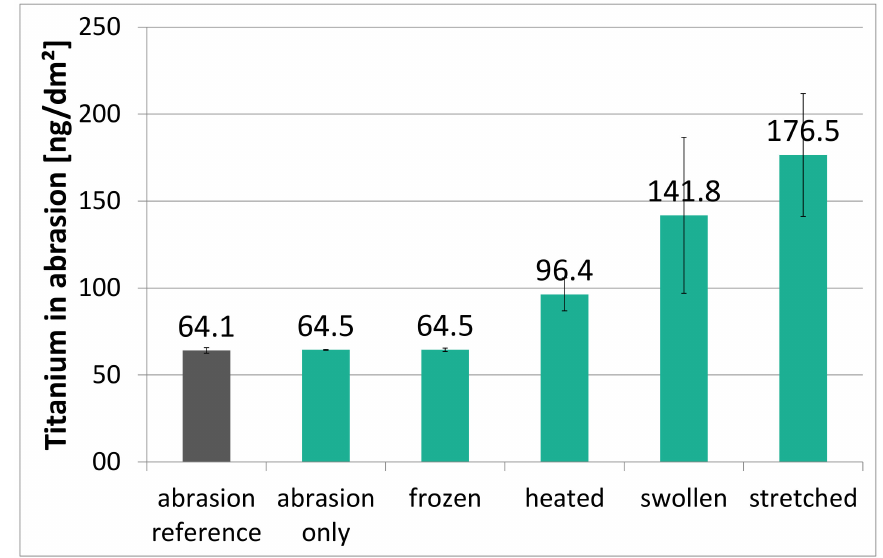
Figure 6. Titanium detected in the abrasion after stressing of the 1000 mg/kg TiN in LDPE